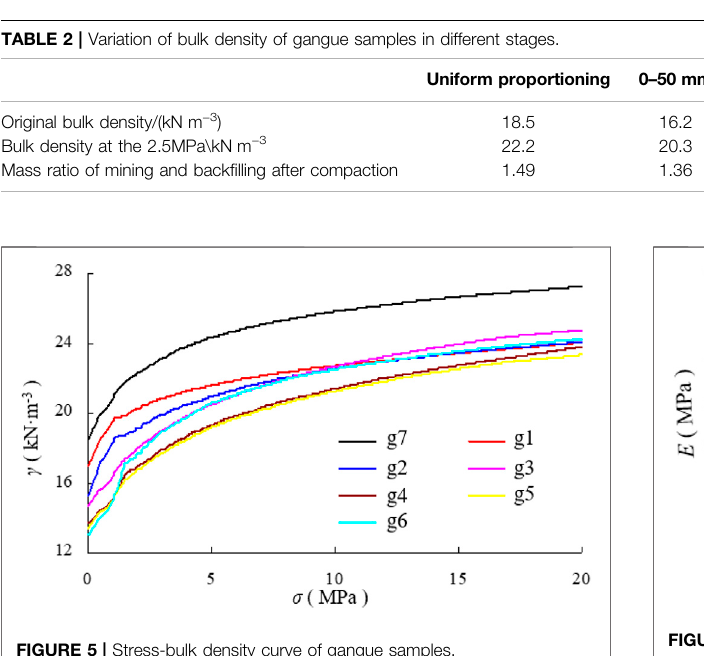
FIGURE 5 | Stress-bulk density curve of gangue samples.